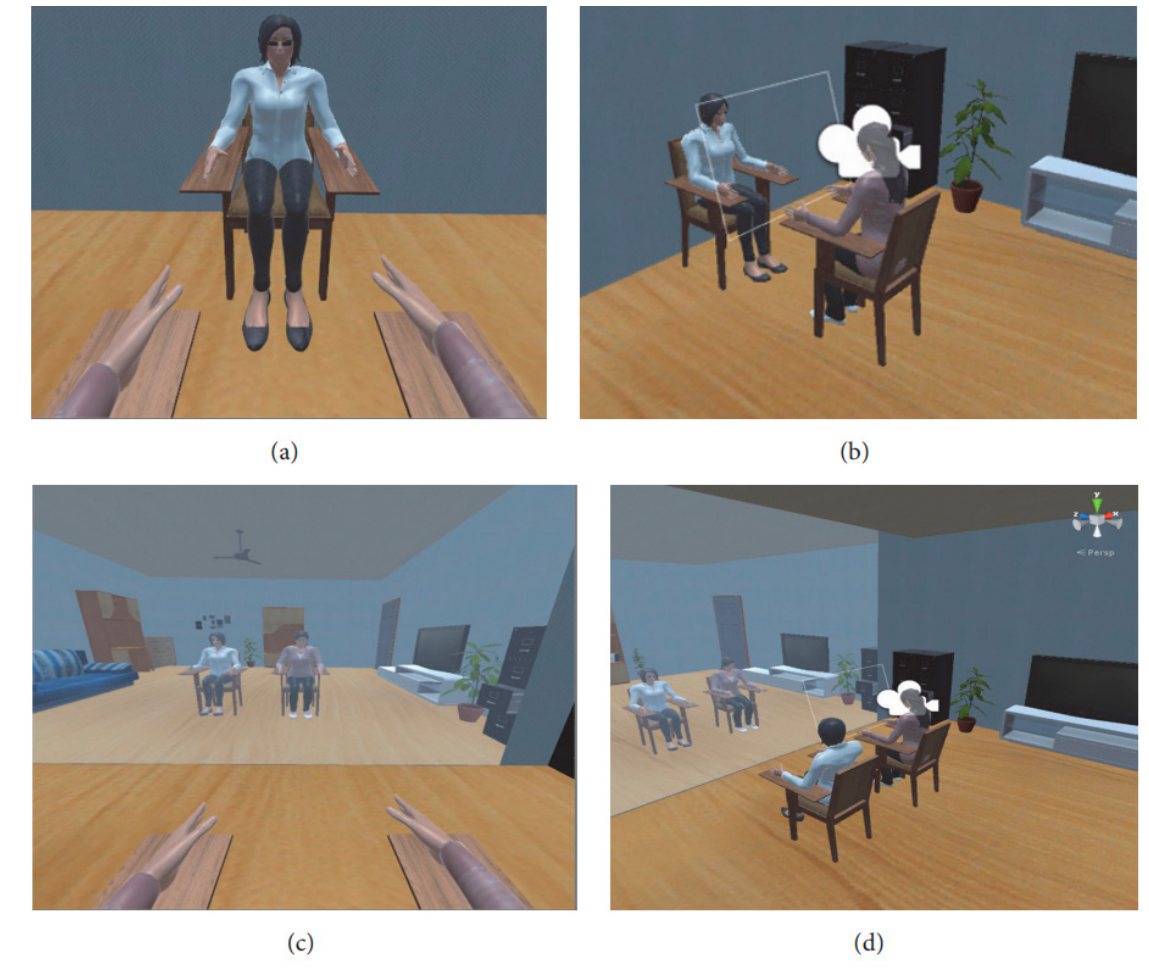
Figure 15. The VR environment: ( a , c ) patient views; ( b , d ) world views; ( a ) the therapist in front of the patient; ( c ) the therapist on the left side of the patient with mirror in the front [105]. Table 2. Summarizes some of the presented paper details such as subject signal type and electrode